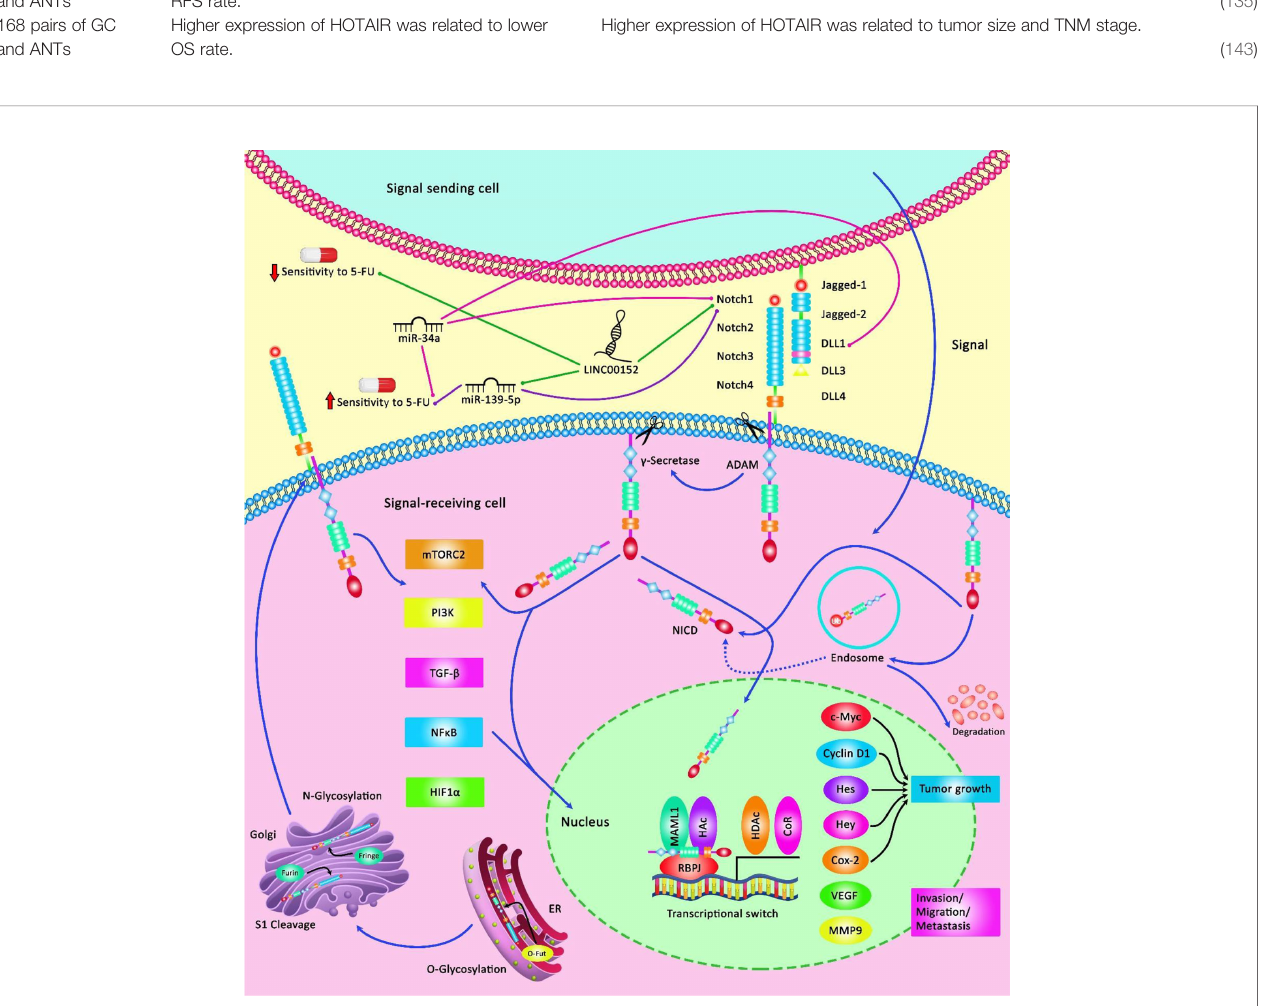
FIGURE 3 | A schematic illustration of the Notch signaling pathway involved in the regulation of response of cancer cells to 5-FU via various non-coding RNAs. Notch signaling cascade is involved in the various processes of normal morphogenesis, such as cell growth, apoptosis, as well as the acquisition of drug resistance. LINC00152 could elevate tumor cell migration and invasion, and confer 5-FU resistance in colorectal cancer via modulating the expression level of NOTCH1 through sponging miR-139-5p and downregulating its function from enhancing CRC development (134). Additionally, miR-34a acts as a tumor suppressor and could directly downregulate the expression level of DLL1 as a ligand of the Notch signaling cascade, and thereby could inhibit tumor growth under 5-FU treatment by promoting chemosensitivity to this agent